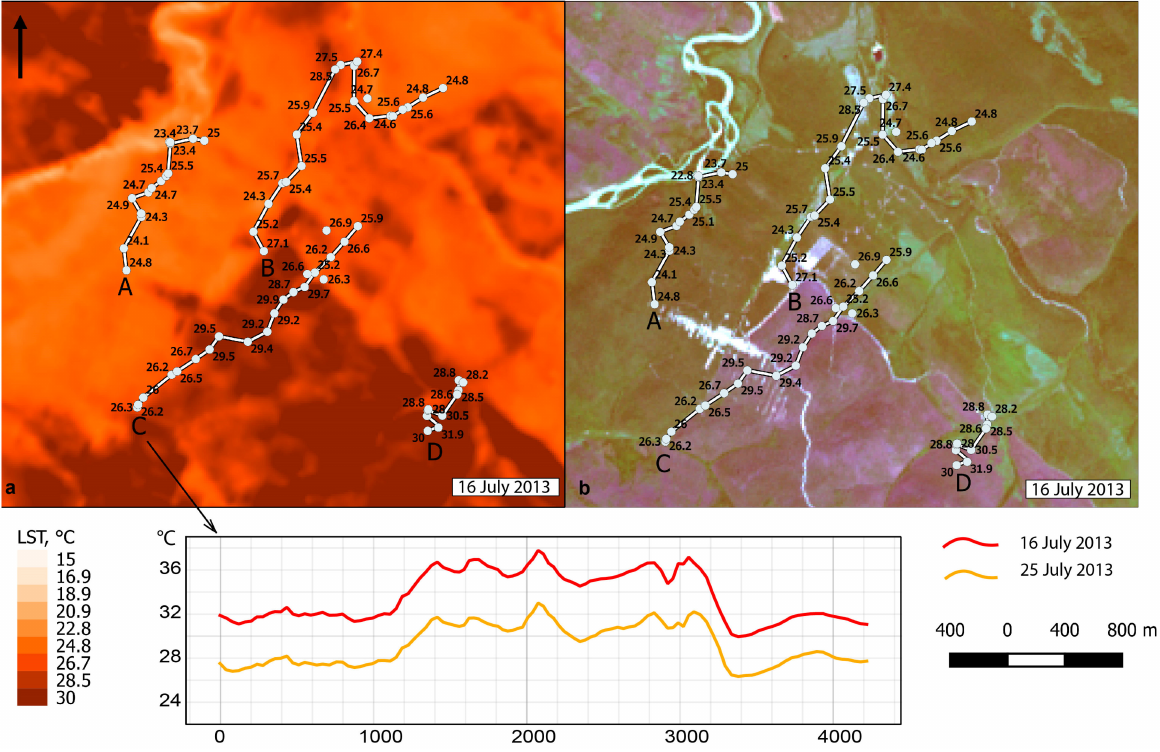
Figure 2. ( a ) The spatial pattern of the LSTs in the summer period. ( b ) Synthesized natural color composite (bands 4-3-2) Landsat 8 image. Jagged lines on the map show temperature profiles drawn along the landscape transects. Profile “A” crosses mainly non-permafrost landscapes. Profiles “B” and “C” pass through the areas with the greatest diversity of geocryological conditions (this is especially true of profile “C”). Profile “D” crosses permafrost landscapes developed on close-to- surface permafrost. The low part shows LST changes along profile “C” obtained by processing two Landsat images (16 July 2013 and 25 July